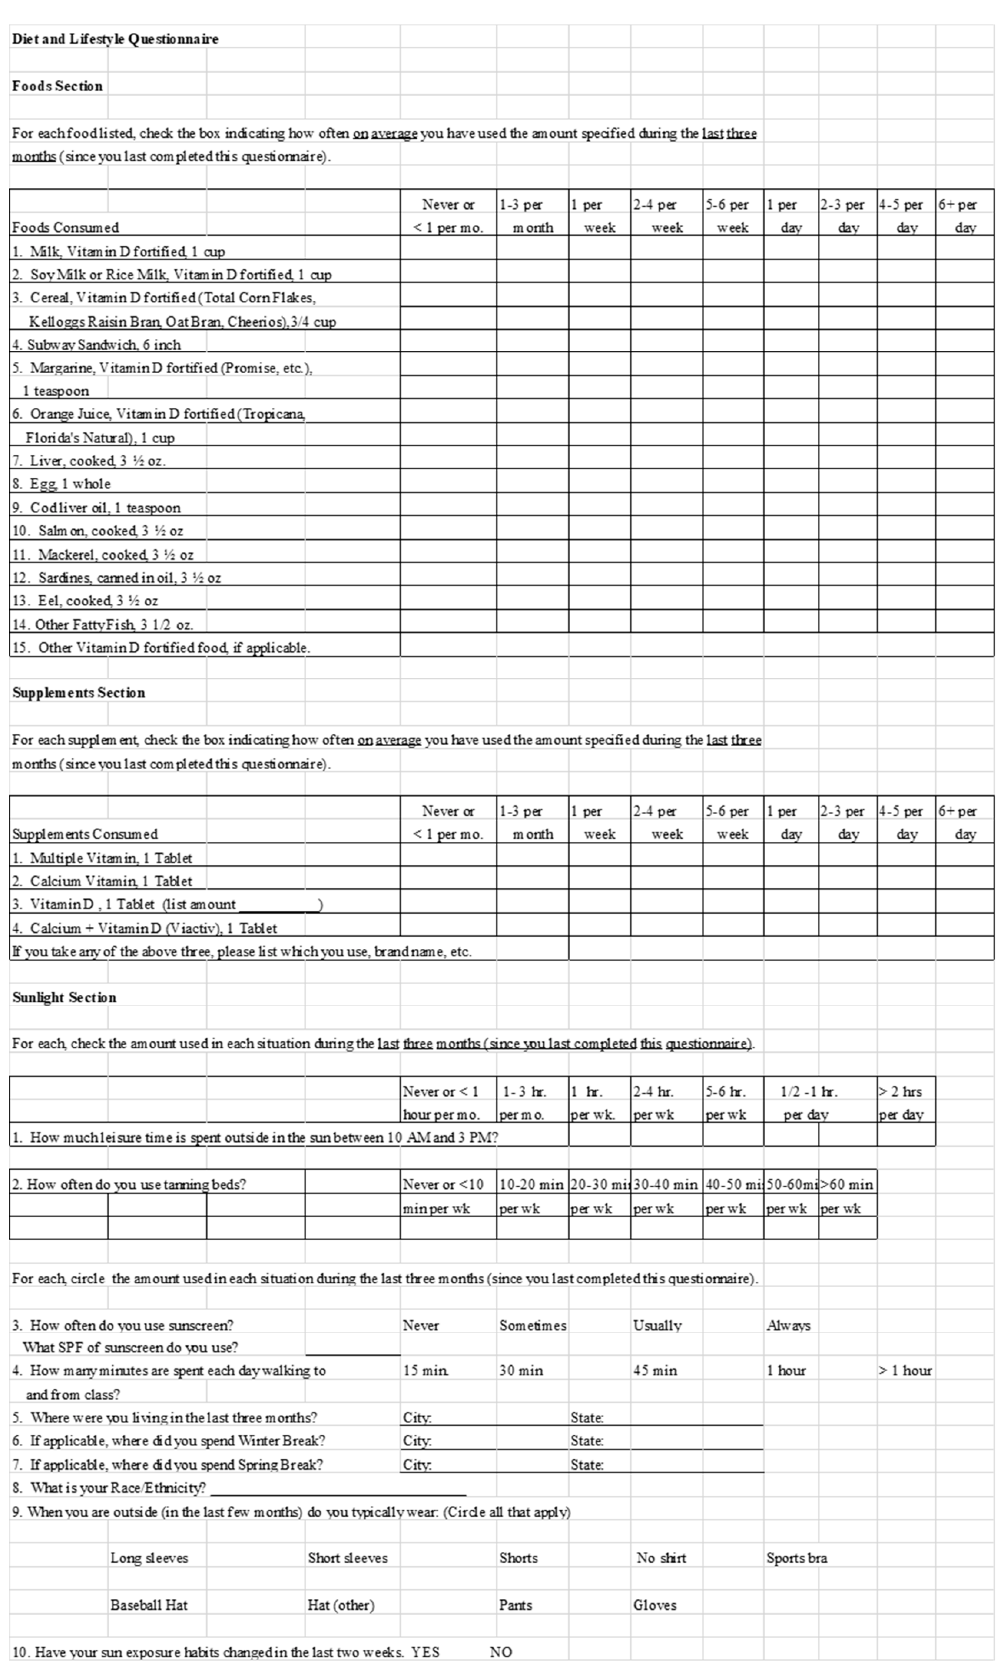
Figure A1. Vitamin D Food Frequency and Lifestyle Questionnaire.